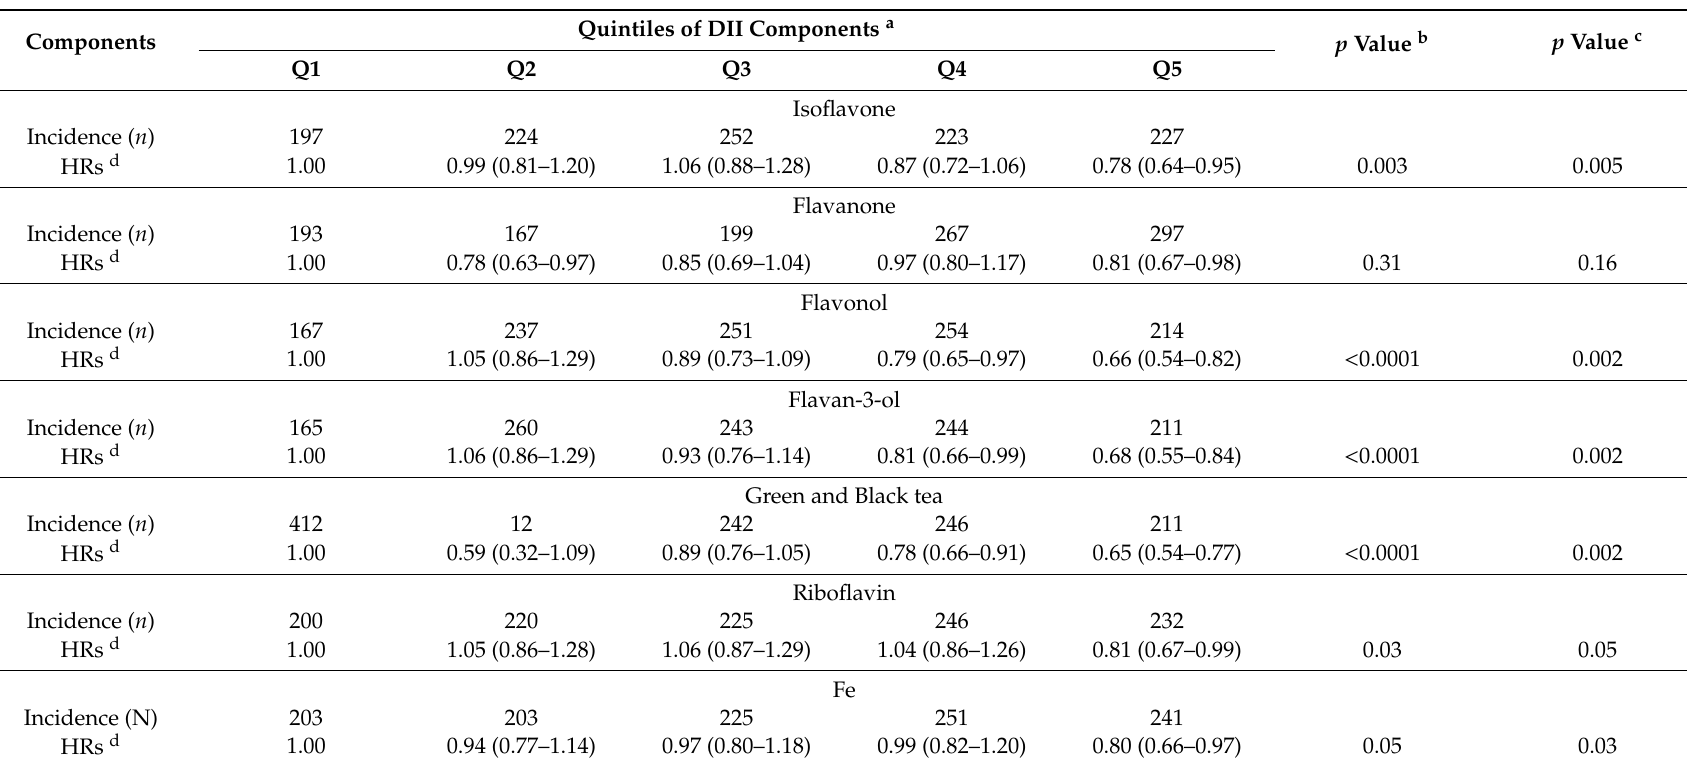
Table 3. Multivariable Cox proportional Hazard Ratios (HRs) with 95% Confidence Intervals (CIs) for components e ff ecting reduced DII level in